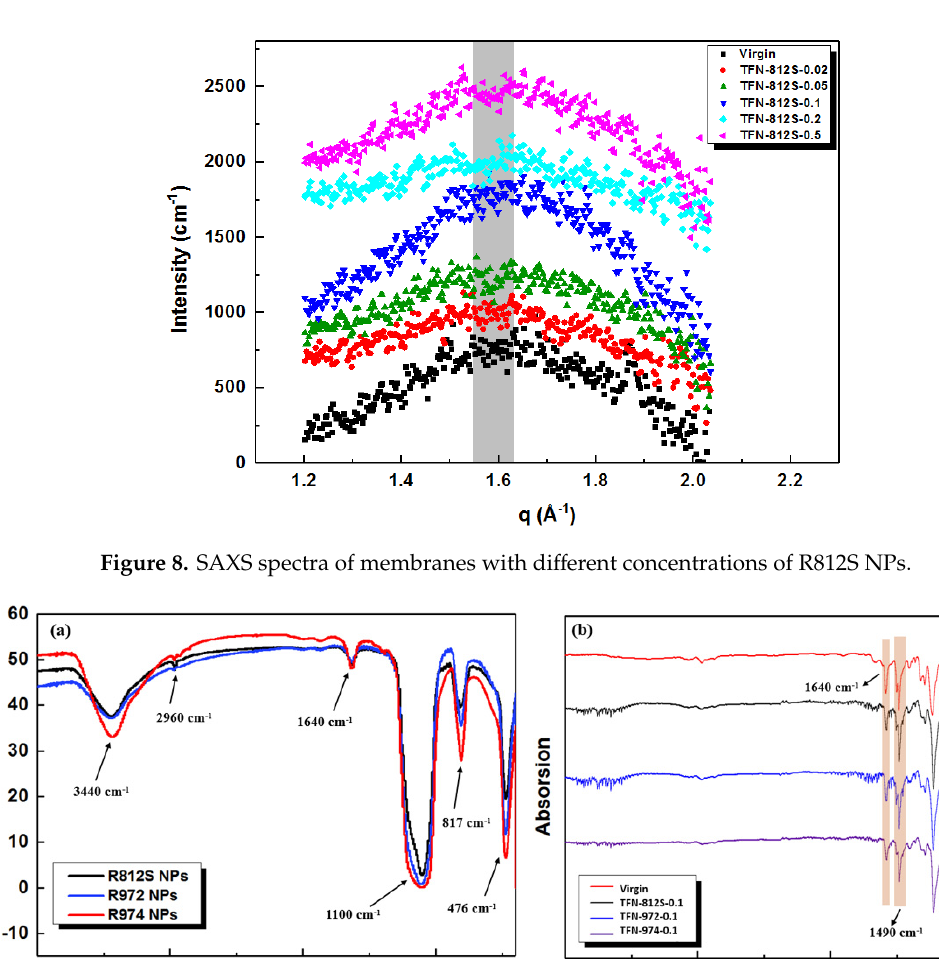
Figure 9. ( a ) FT-IR spectra of the different types of NPs and ( b ) ATR-FTIR spectra of the TFN membranes containing different NPs at the concentration of 0.1% ( w / v ).